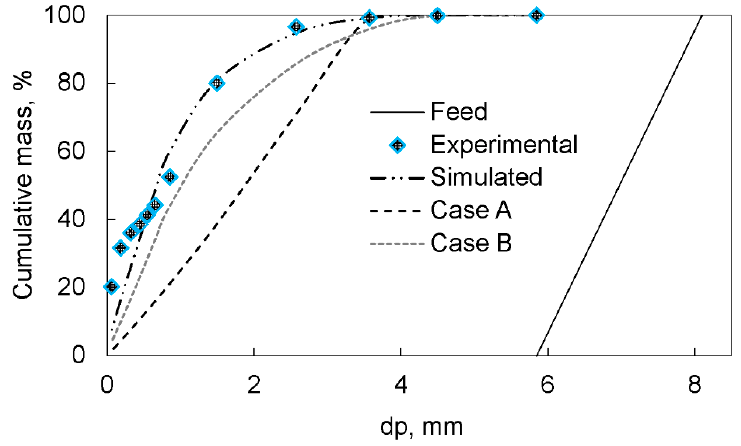
Figure 20. Example of simulation using different breakage function parameters.